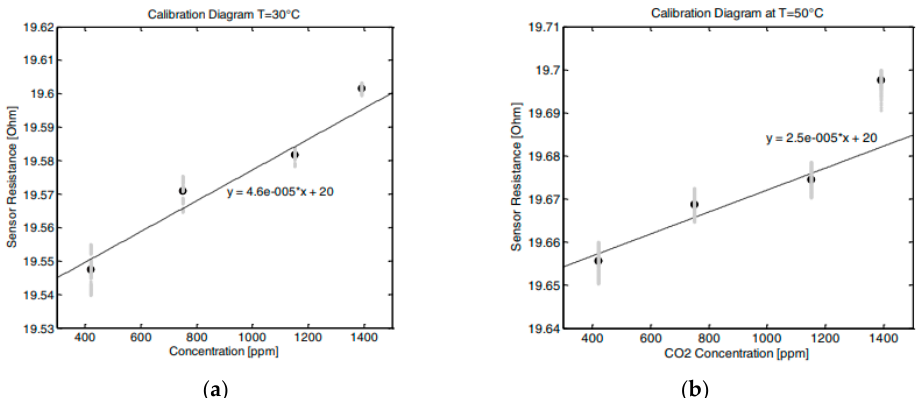
Figure 24. An inkjet printed sensor response to CO 2 gas at two different temperatures. Reproduced with permission from reference [117].